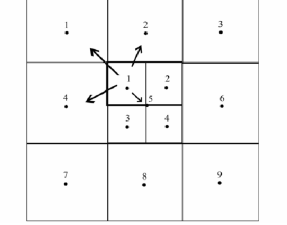
Figure 4. Sketch map for downscaling transformation